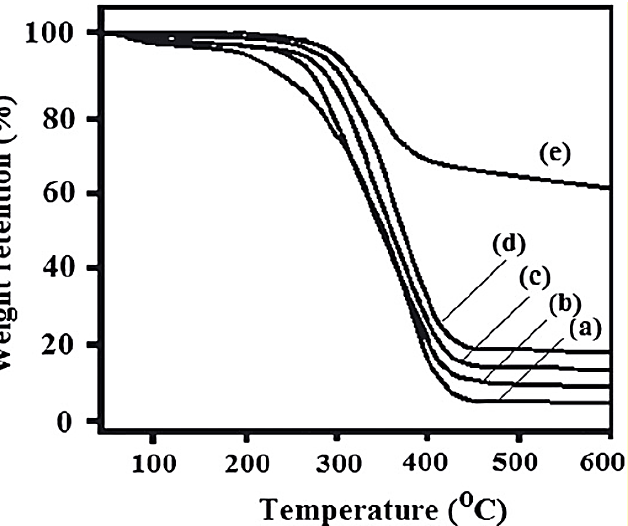
Table 1. TGA data for PTh, GO and PTh/GO composites [87].